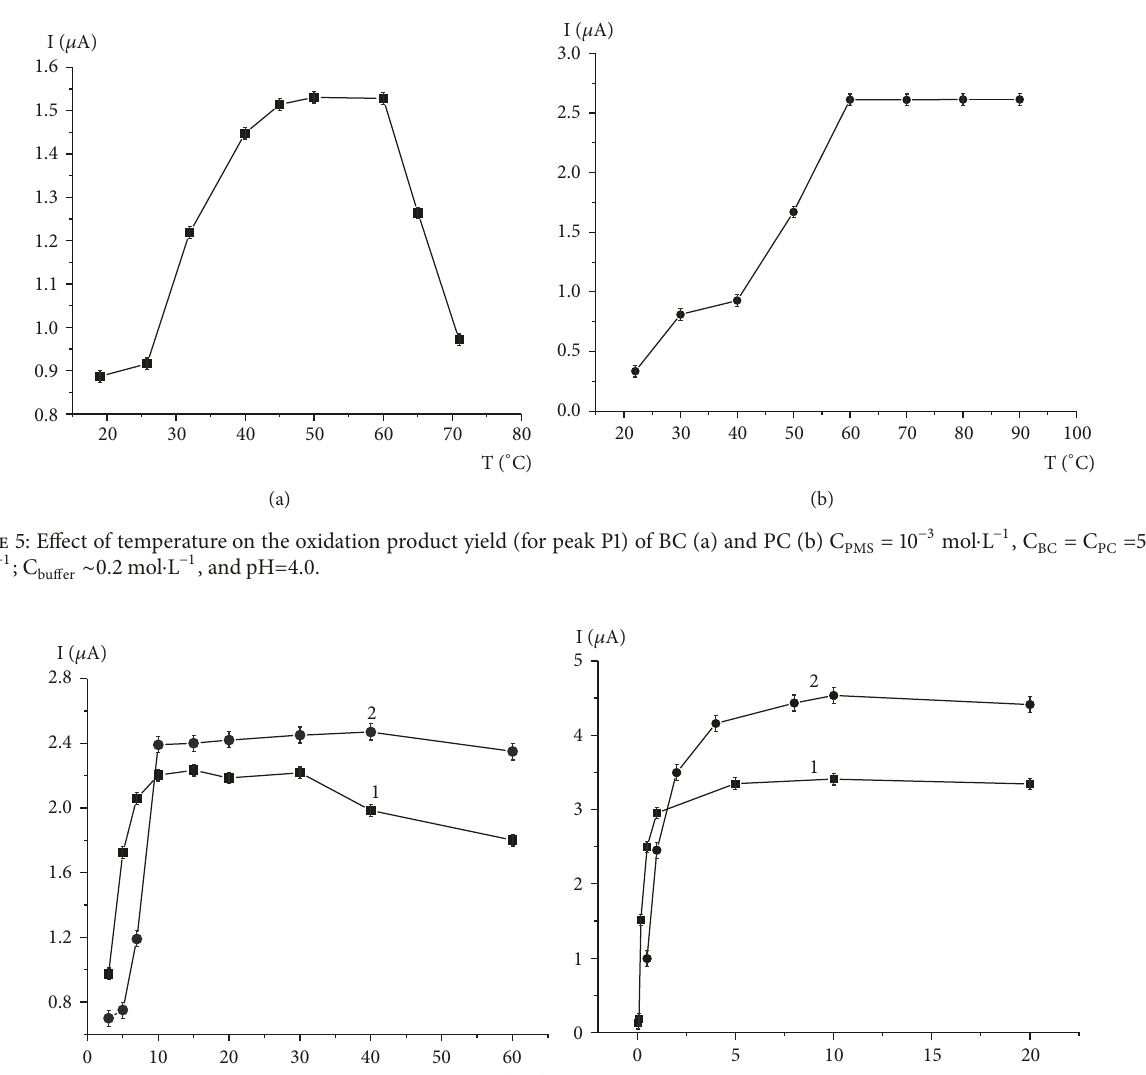
Figure 6: Dependence of the peak P1 current of BC (1) and PC (2) derivatives on the oxidation time (a), C PMS = 10 −3 mol ⋅ L −1 , and on the molar excess of PMS (b), C BC = C PC = 5 ⋅ 10 −5 mol ⋅ L −1 , pH